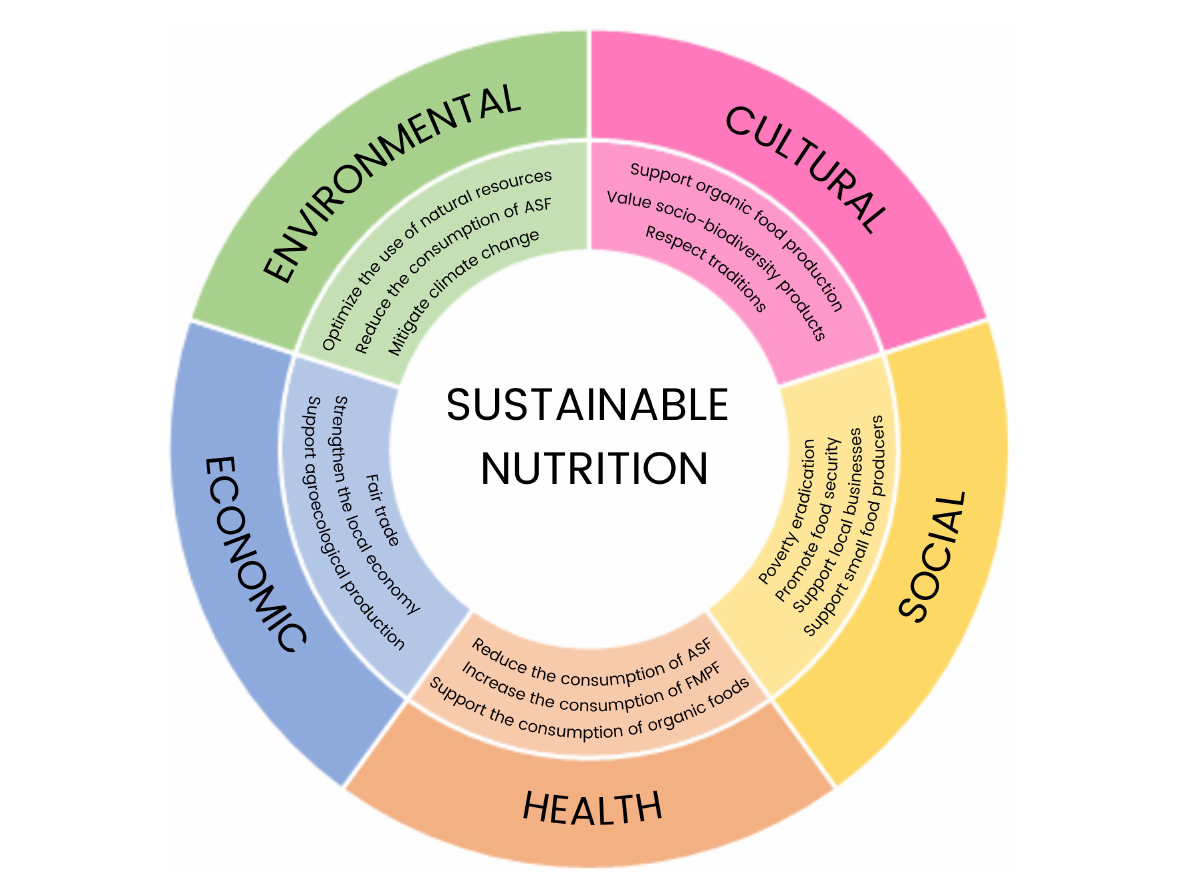
FIGURE3 Dimensions of Sustainable Nutrition: Symbol of Life. ASF, Animal source foods; FMPF: Fresh or minimally processed foods (von Koerber et al.,